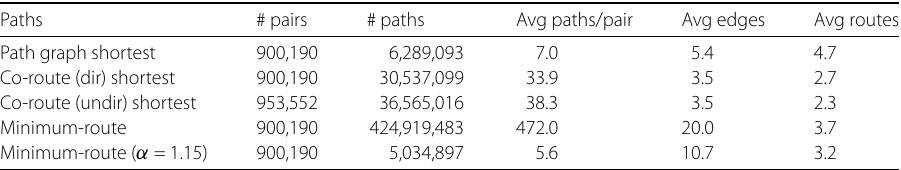
Table 3 Path statistics for shortest paths through the path, directed and undirected co-route graphs, and minimum-route paths with and without filtering Paths # pairs # paths Avg paths/pair Avg edges Avg routes Path graph